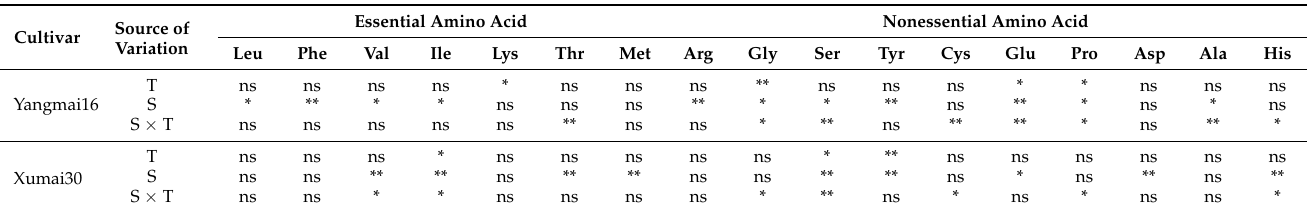
Table 2. Effects of different low-temperature intensities (T), stages (S), and their interactions (T × S) on the amino acids of